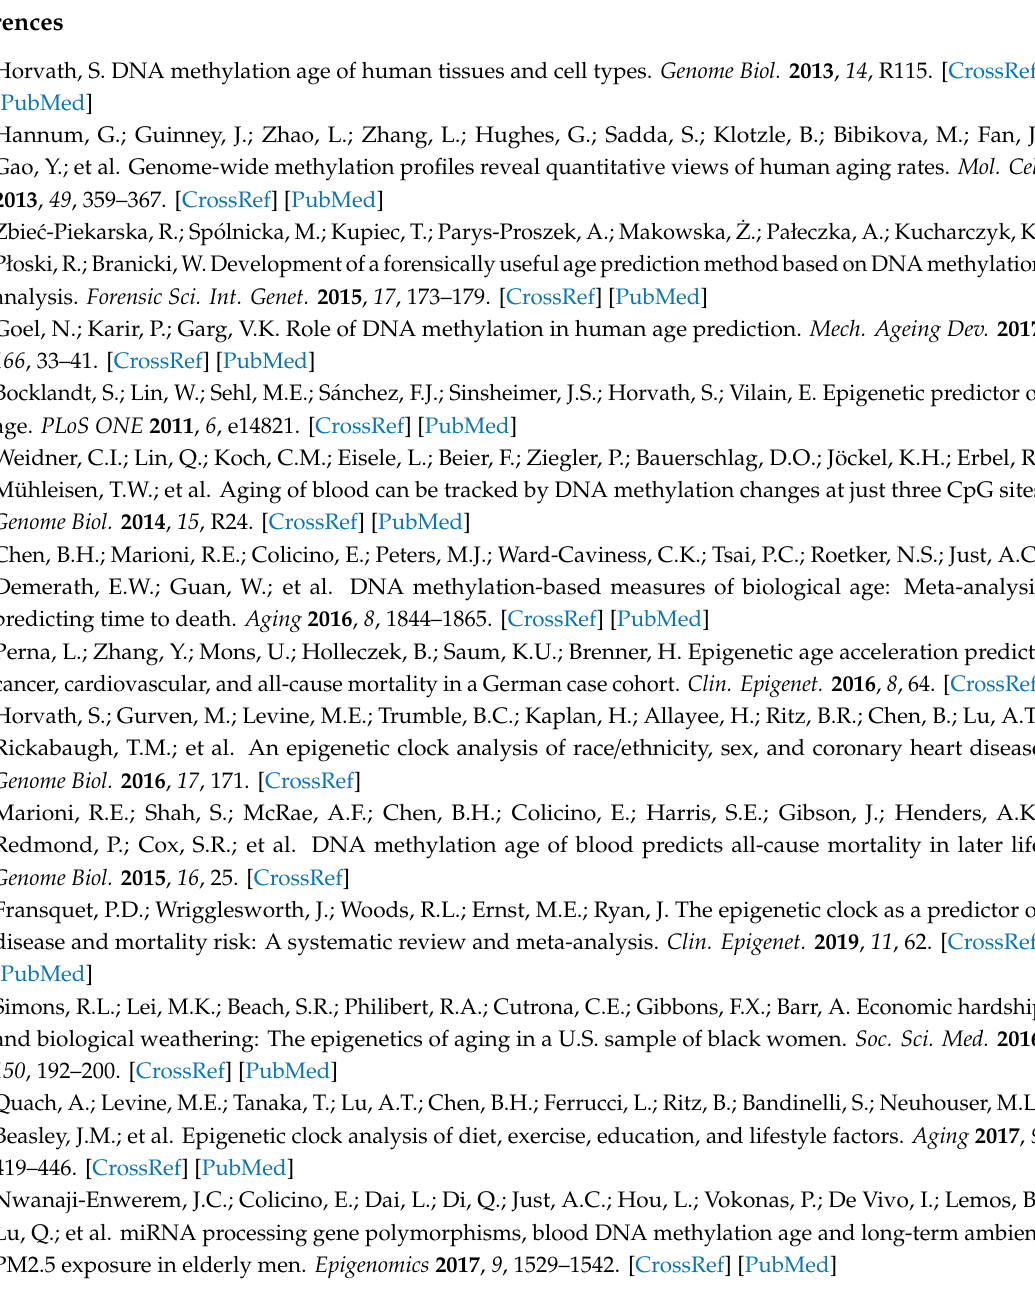
Table S1: Details of markers, AgePlex sequences to analyze, CpG sites and location of the prediction model. Table S2: LTL and Telomerase expression at enrolment T0 and after 60 days of relaxing practices